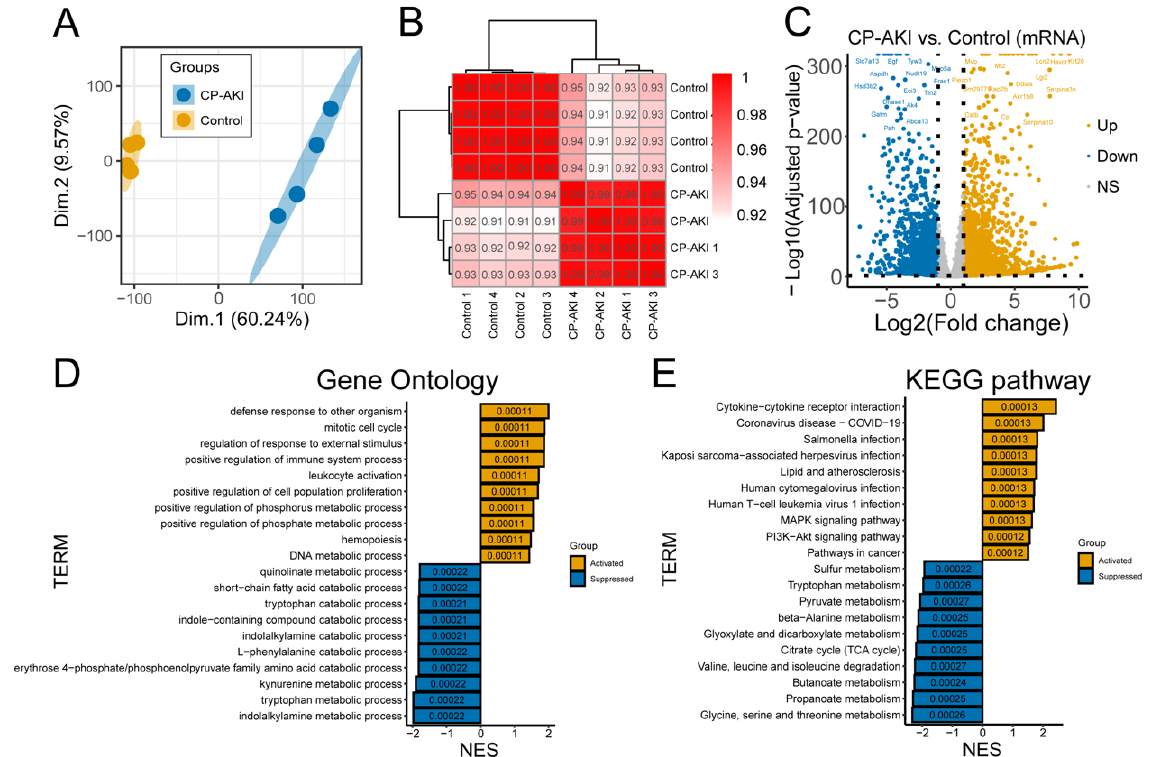
Figure 2. Expression profiles revealed by whole-transcriptome RNA sequencing (RNA-seq). ( A ) Prin- cipal component analysis (PCA) of control and CP-AKI samples. ( B ) Spearman correlation analysis among samples. ( C ) Volcano plot of the CP-AKI group’s differentially expressed genes (DEGs) versus the control group. ( D , E ) Gene set enrichment analysis (GSEA) of the CP-AKI group versus the control group by clusterProfiler. Gene Ontology (GO) ( D ) and Kyoto Encyclopedia of Genes Genomes (KEGG) pathways ( E ) were analyzed at the mRNA level. p < 0.05 was considered to indicate significant